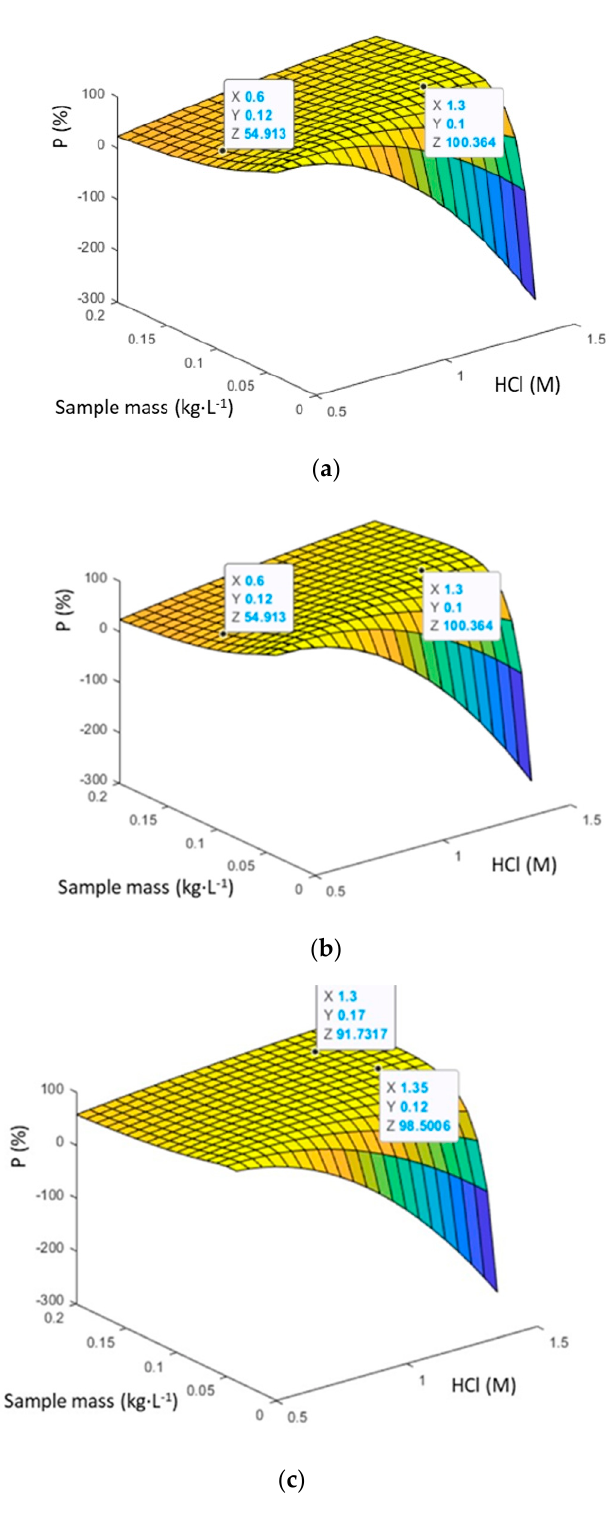
Figure 9. 3D plots of P dissolution depending on HCl concentration and sample mass per 1 L: ( a )